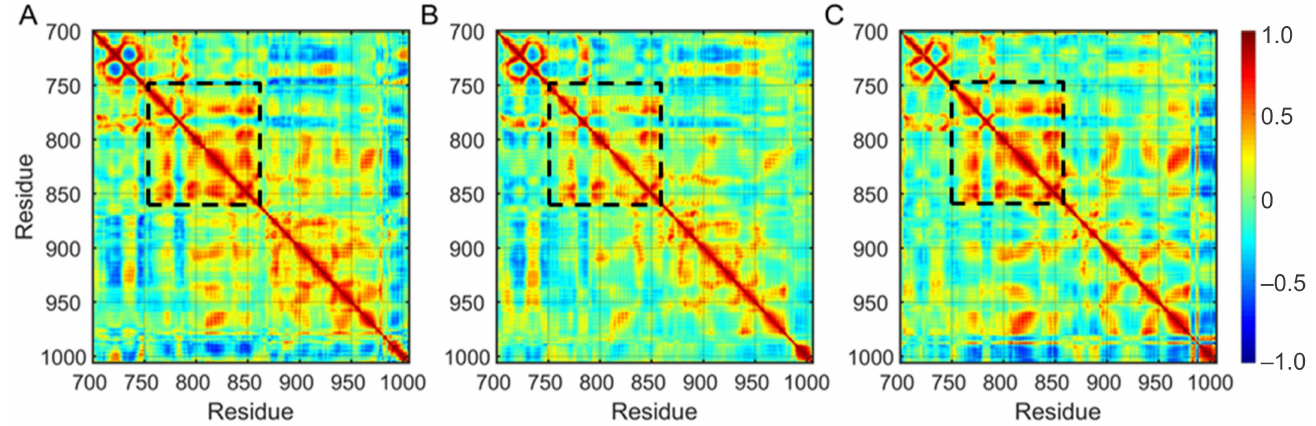
Figure 3. The covariance matrix maps of EGFR in the APO forms: ( A ) G719S-APO, ( B ) G719S/L858R- APO, and ( C ) G719S/L861Q-APO. The positively correlated regions existing in all APO systems are demonstrated by a black square